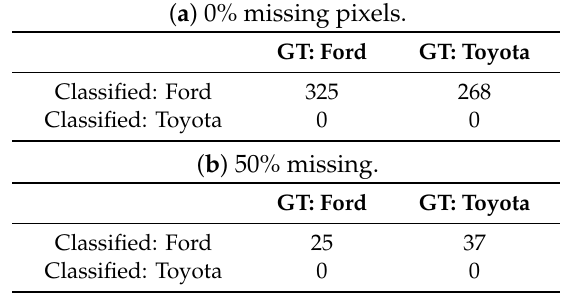
Table 5. Confusion matrices for the JHU balcony experiment with YOLO classification.